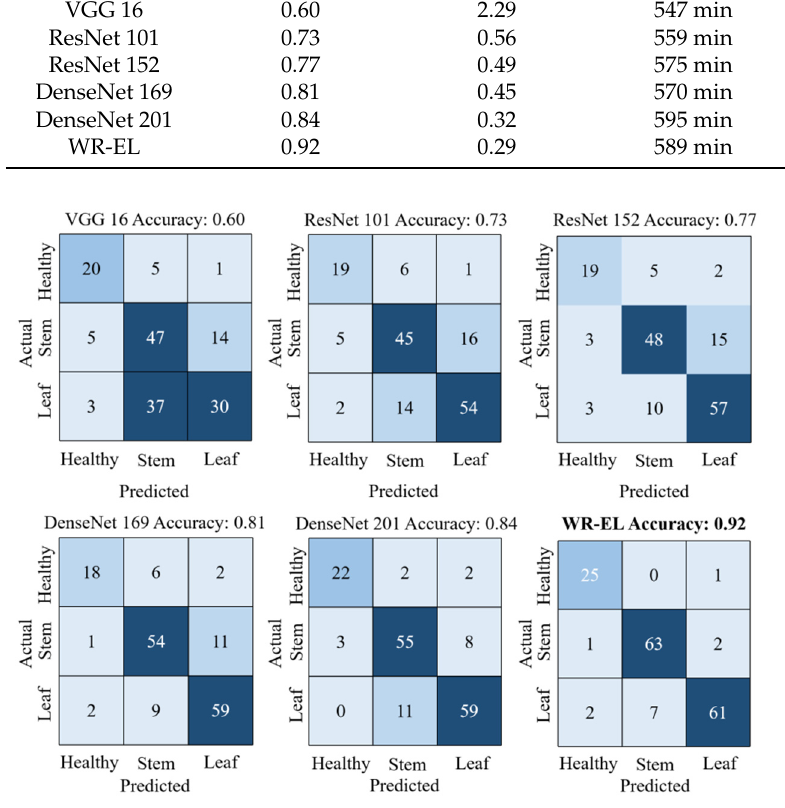
Figure 8. Confusion matrix for each model.